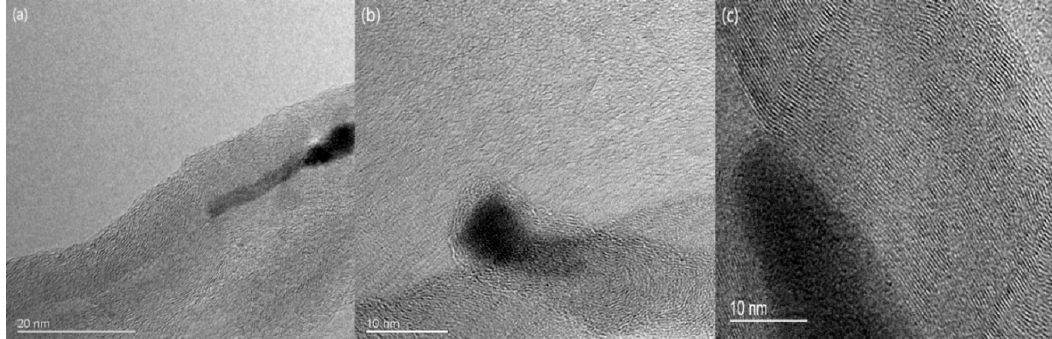
Figure 2. TEM images of the vertically-aligned CNTs, synthesized by Ni–Al–Ni (1 nm–0.5 nm–1 nm) catalyst. ( a ) Structure of the multi-wall carbon nanotubes (MWCNTs) grown at 340 °C, ( b ) the tip growth of the MWCNTs grown at 340 °C, and ( c ) structure of the MWCNTs grown at 450 °C.